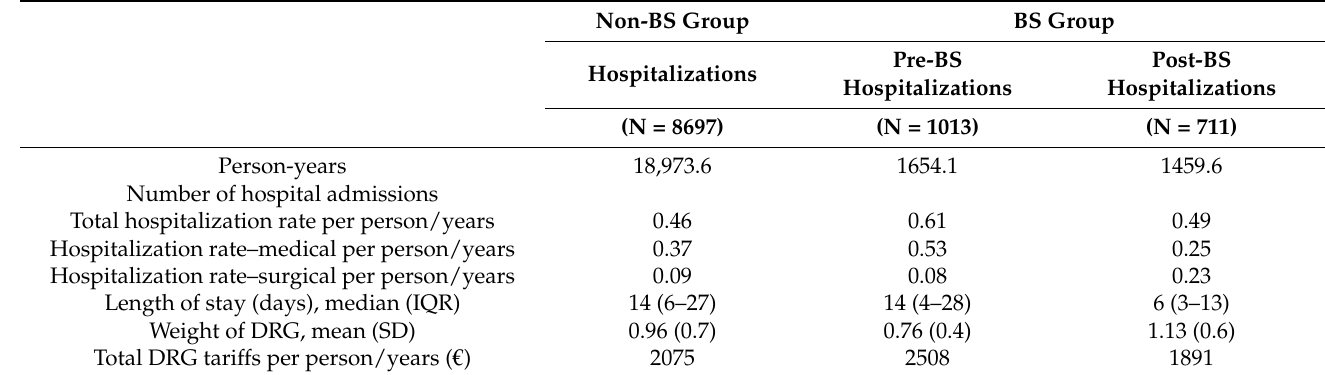
Table 3. Characteristics and rate of hospitalizations by bariatric